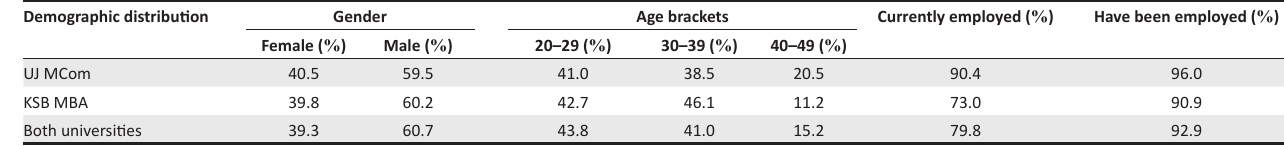
TABLE 4a: Profiles – University of Johannesburg MCom students versus Krakow School of Business MBA students. Demographic distribution